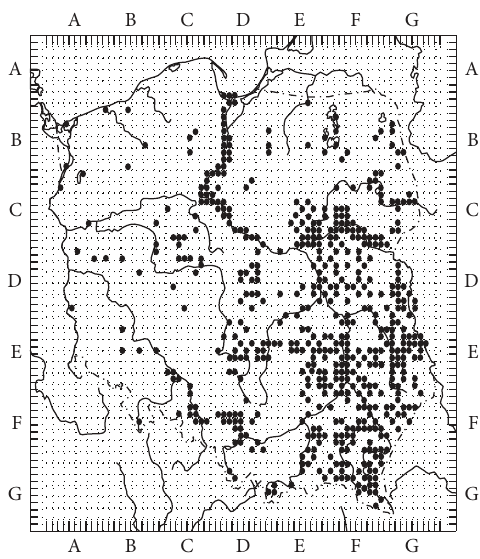
Figure 1: Distribution map of Rumex confertus in Poland using the ATPOL grid square system